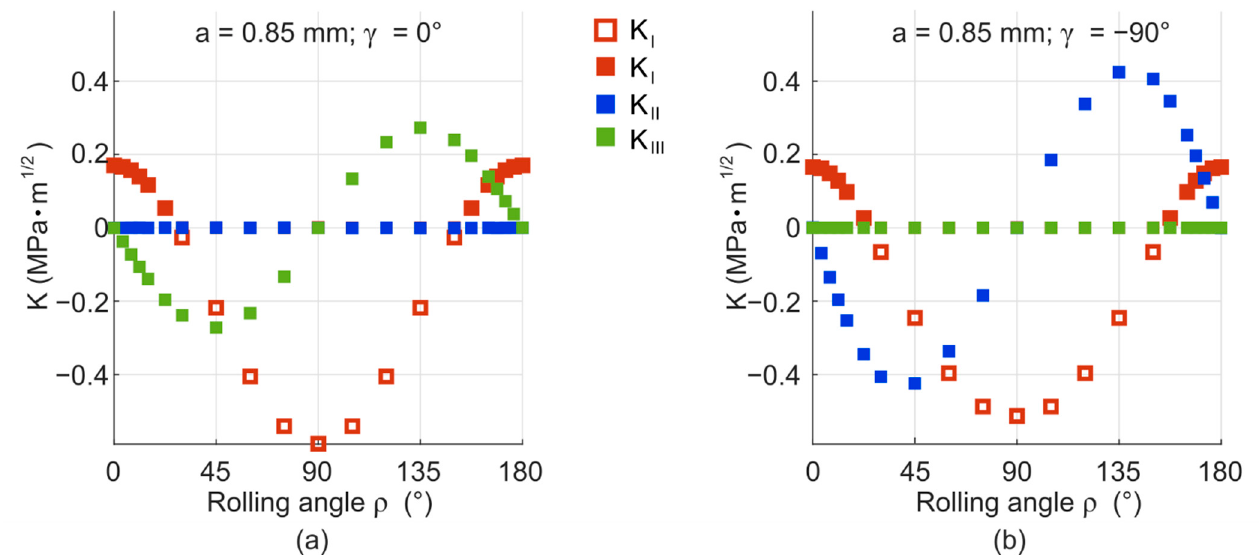
Figure A3. Course of stress intensity factors during rotation in the cylinder D × L = 6 × 6 mm 2 , load F = 350 N, a = 0.85 mm, position on the crack front; ( a ) γ = 0°; ( b ) γ = − 90°.